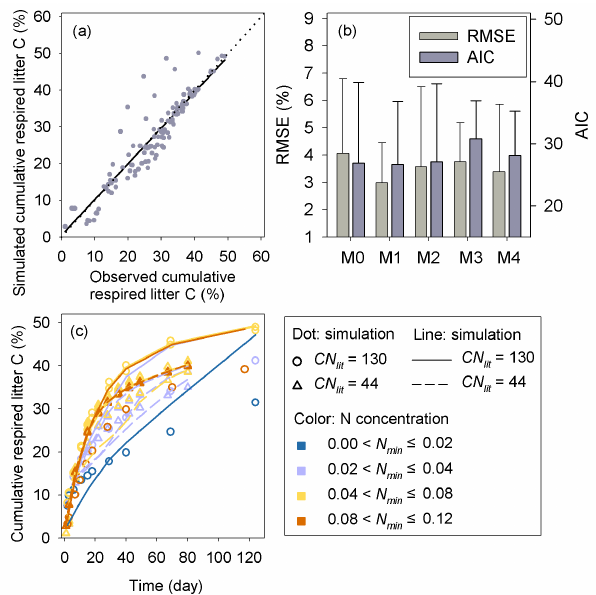
Figure A2. Comparison between simulated cumulative respired lit- ter C with f ( N min ) (inhibition effect of soil mineral N on litter de- composition) calculated by Eq. (6) and the observed results from incubation experiments. In panel (b) , M0–M4 denote the five ver- sions of litter decay model in Table 1. M4 denotes the model which used Eq. (2) to calculate the dynamic CUE and Eq. (6) to calculate f ( N min ) .